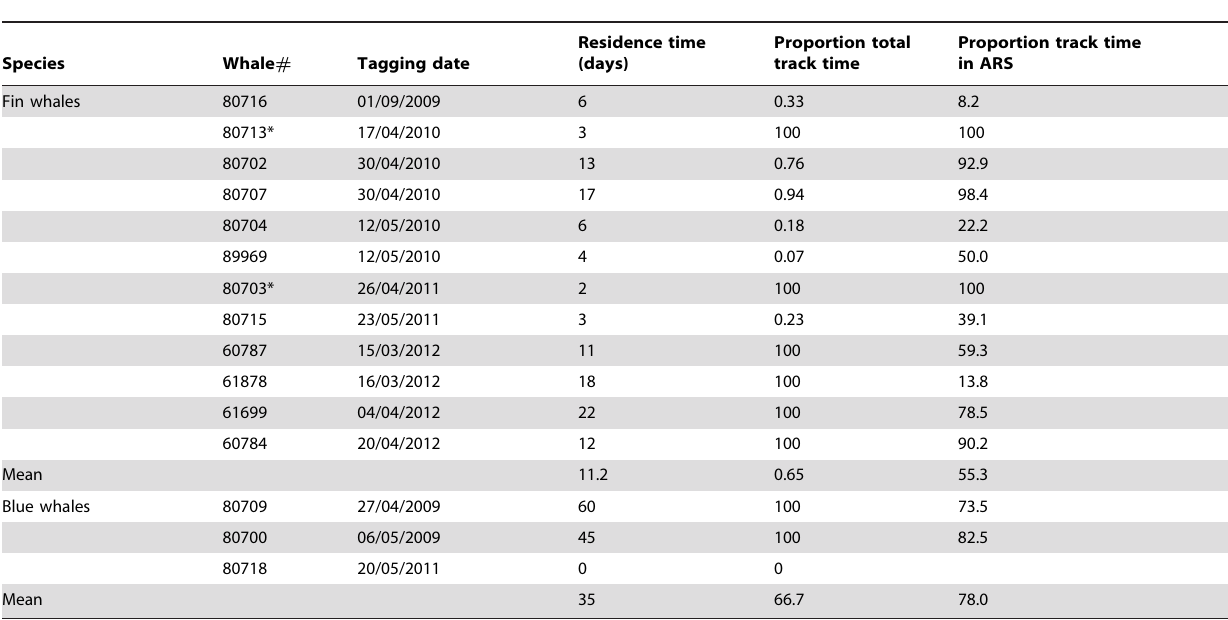
Table 2. Estimates of fin and blue whale residence time and time spent in ARS in the Azores.